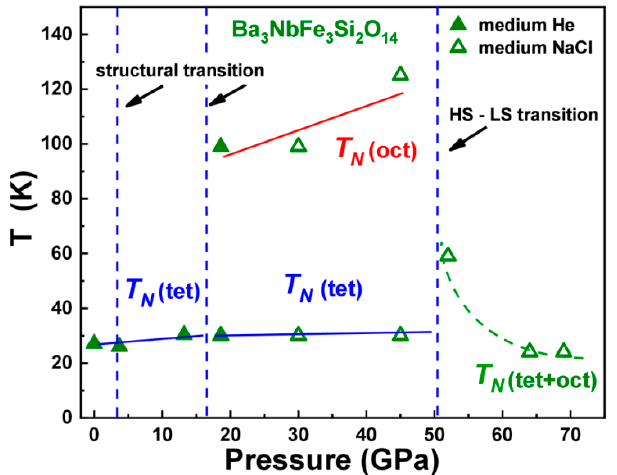
Figure 13. The magnetic P-T phase diagram of langasite Ba 3 NbFe 3 Si 2 O 14 demonstrating an occurrence of three magnetic phases with different values of T N in different intervals of pressure. Solid lines correspond to the Neel temperatures and separate magnetic states of iron in tetrahedral and octahedral fractions of the sample. A dashed green line corresponds to the magnetic behavior of the compound in the low-spin state. Vertical dashed lines separate the different crystal and electronic phases.